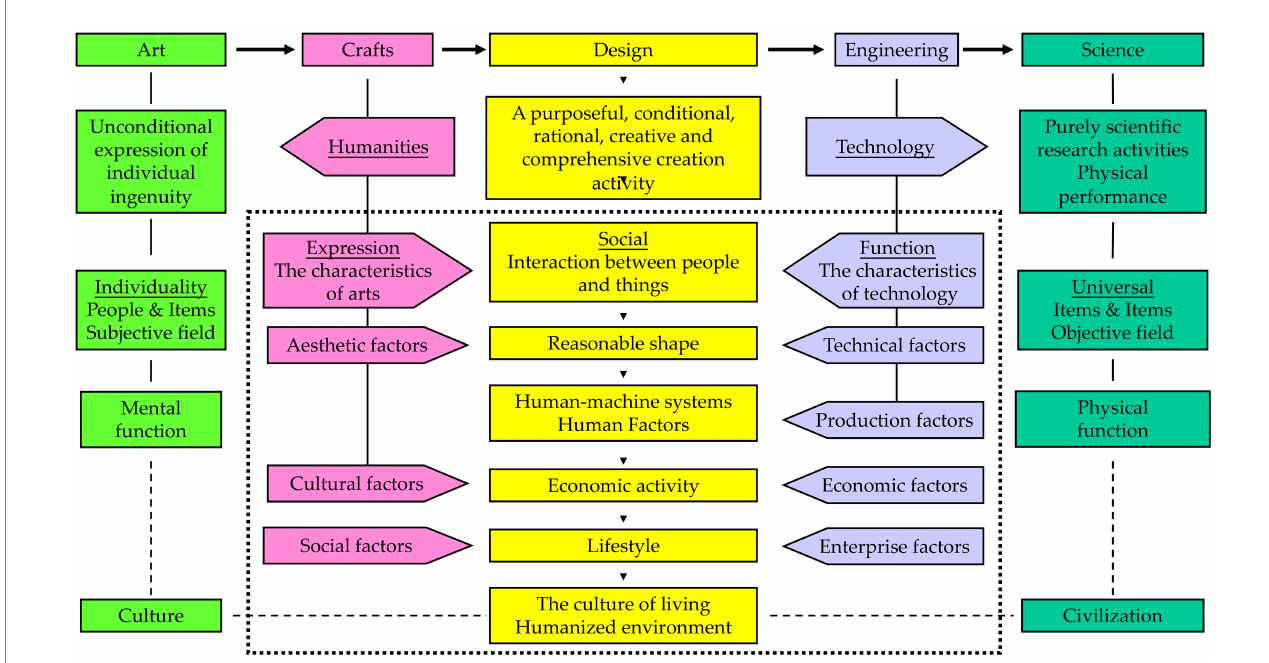
FIGURE 1 The essence of design: the balance between art and science (Source: this study).